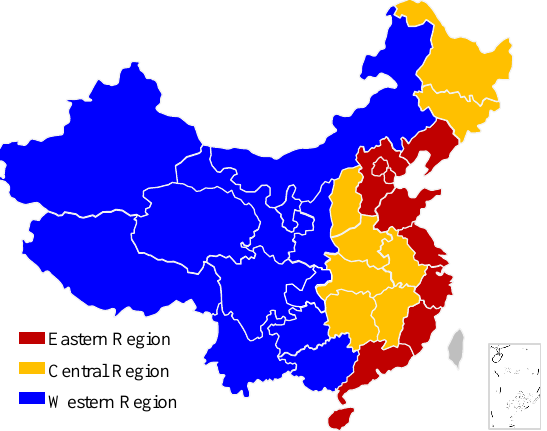
Figure 1. Three regions in China defined by the National Bureau of Statistics.